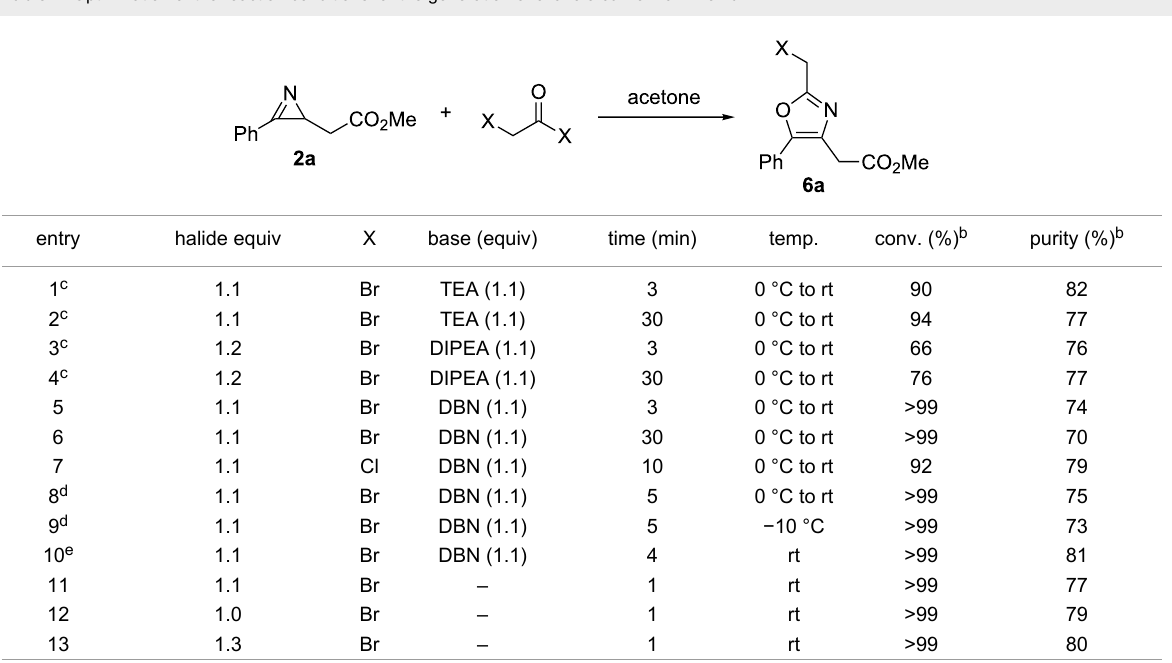
Table 2: Optimization of the reaction conditions for the generation of oxazole 6a from azirine 2a .